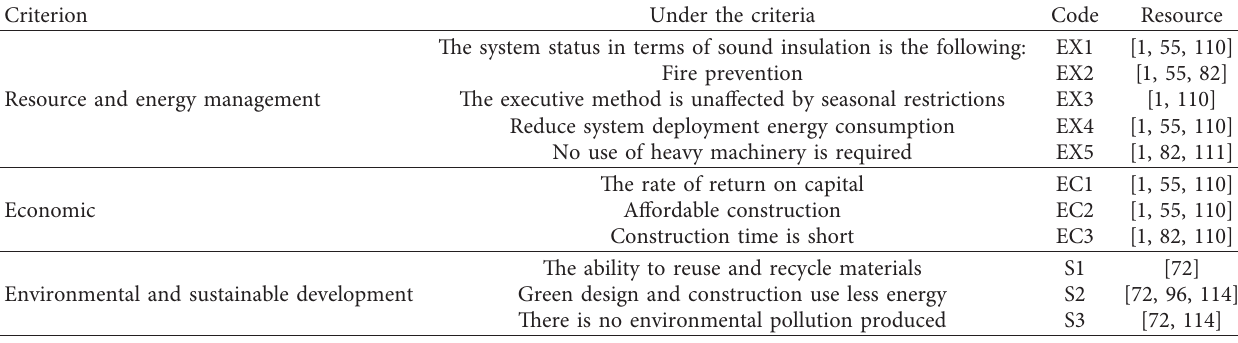
Table 3: Criteria and subcriteria for evaluation of hotel